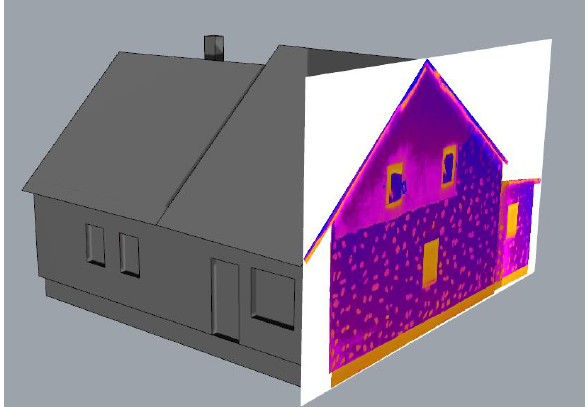
Figure 11. Orthophoto integrated to the 3D model of a test object. Orthophotos and Point clouds generated from thermal images can be valuable data for BIM